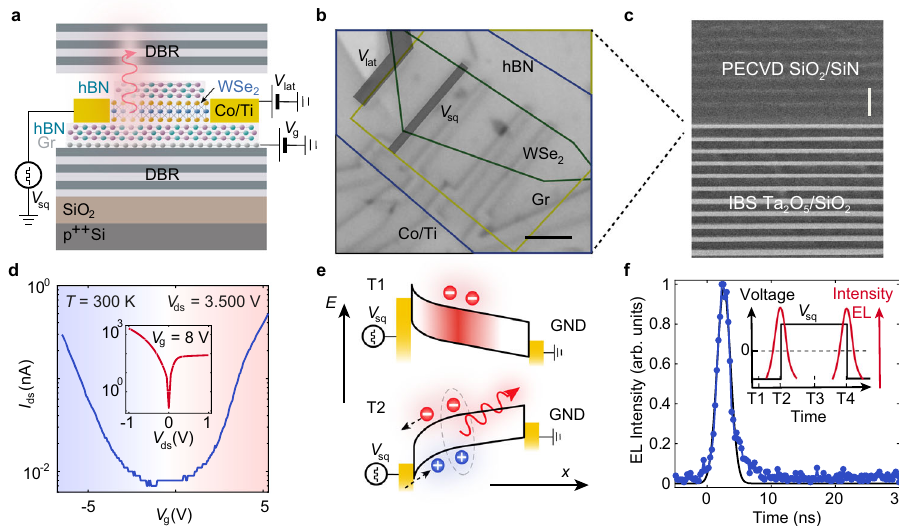
Fig. 1 | Device structure and basic characterization. a Schematics of the device structure. V sq : square voltage pulse. V lat : lateral voltage. V g : gate voltage. b Optical image of the completed device. Scale bar, 4 µ m. c Scanning electron microscopy (SEM) image of the distributed Bragg re fl ector (DBR) cavity. Scale bar, 500nm. d Electrical transport properties of the device, showing ambipolar behavior. Inset showsthedrain-sourcecurrent I ds asafunctionofthedrain-sourcebiasvoltage V ds e Schematicsofexcitonicemissiondrivenbyahighfrequencysquarevoltagepulse.